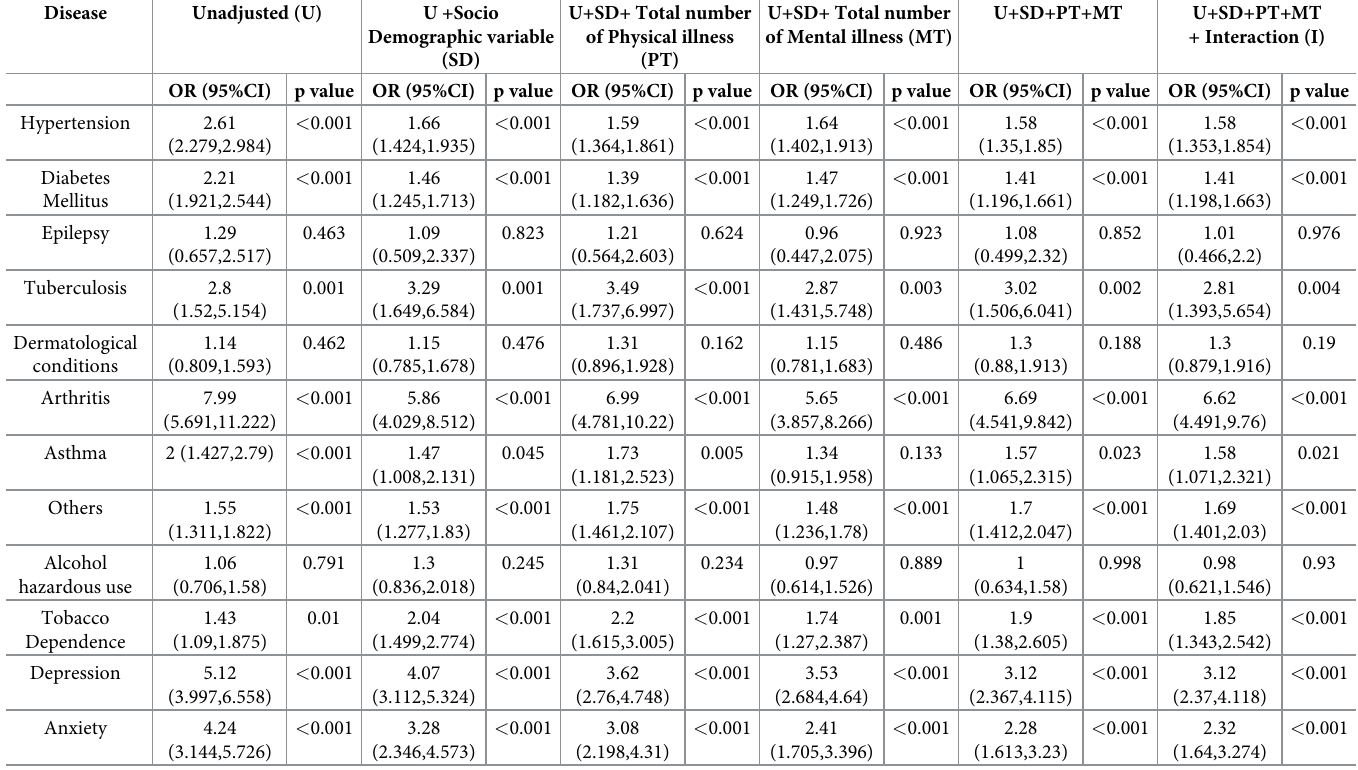
Table 4. Generalized linear effects models of physical and mental health comorbidity in patients with chronic pain.